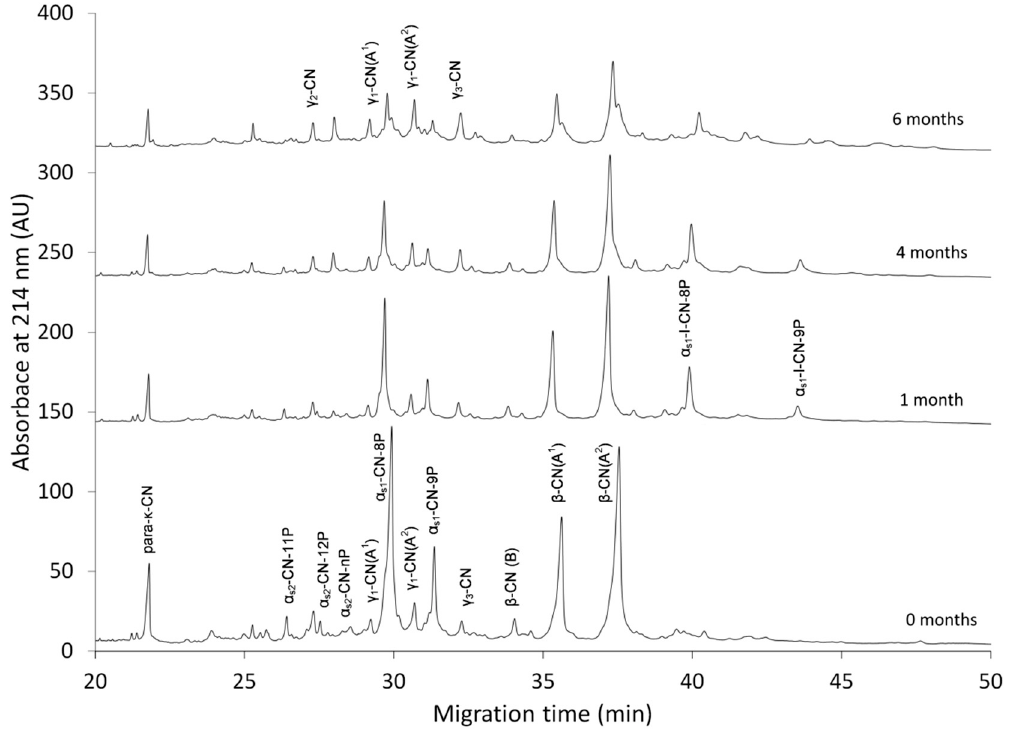
Figure 1. The electropherograms of RO-cheese obtained by CE at 0, 1, 4, and 6 months of